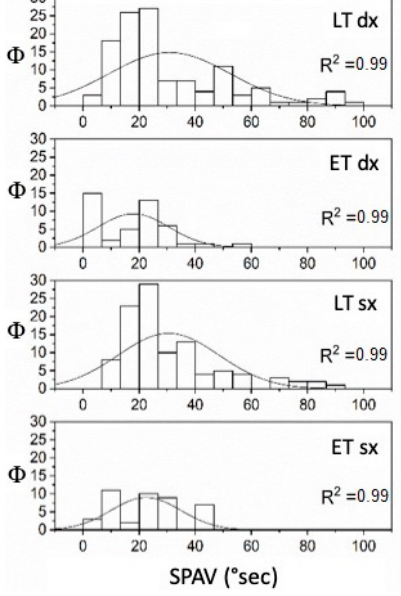
Figure 5. SPAV (°/s) of spontaneous Ny in compensated (LT) and uncompensated (ET) UPVL patients ( Φ = data distribution frequency). The Gaussian peak represents the mean of SPAV frequency in °/s. Frequency distribution in spontaneous SPAV and nor- mal curve fit R 2 = 1 for early time and R 2 = 0.97 for late time. Fit R 2 = 1 for ET and R 2 = 0.97 for LT ( p = 0.001).